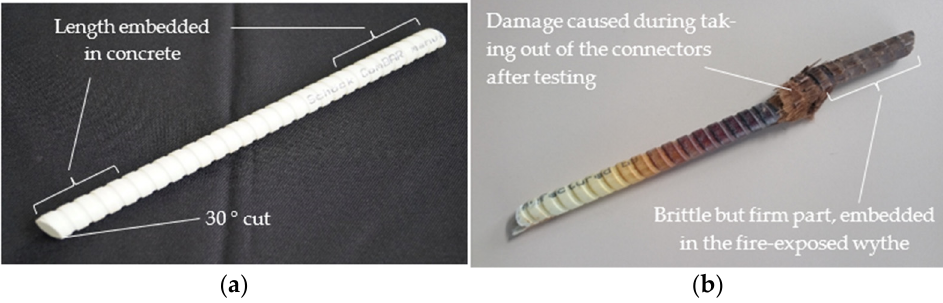
Figure 2. GFRP connectors used as a shear connection between the two concrete wythes, before assembly in the wall ( a ) and after the fire test—Test 3 ( b ).